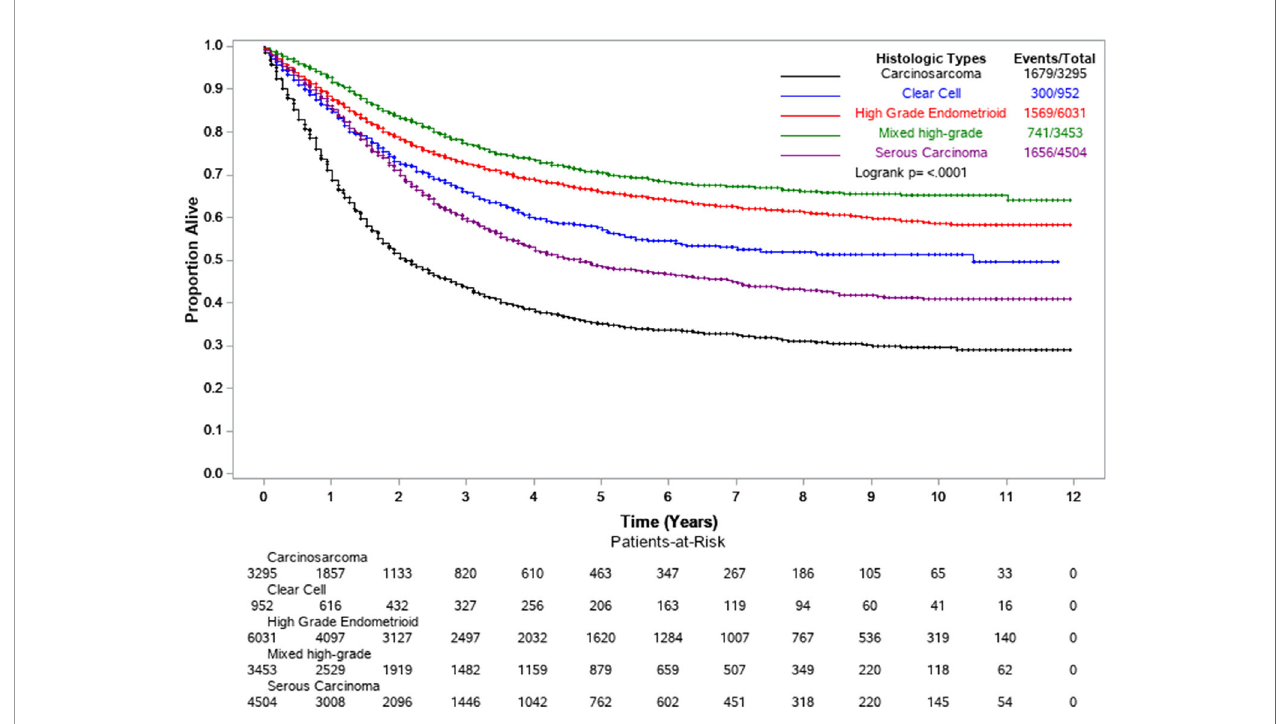
FIGURE 1 | Kaplan-Meier survival curves by EC2 histological subtypes. Florida and New York, 2005 – 2016.